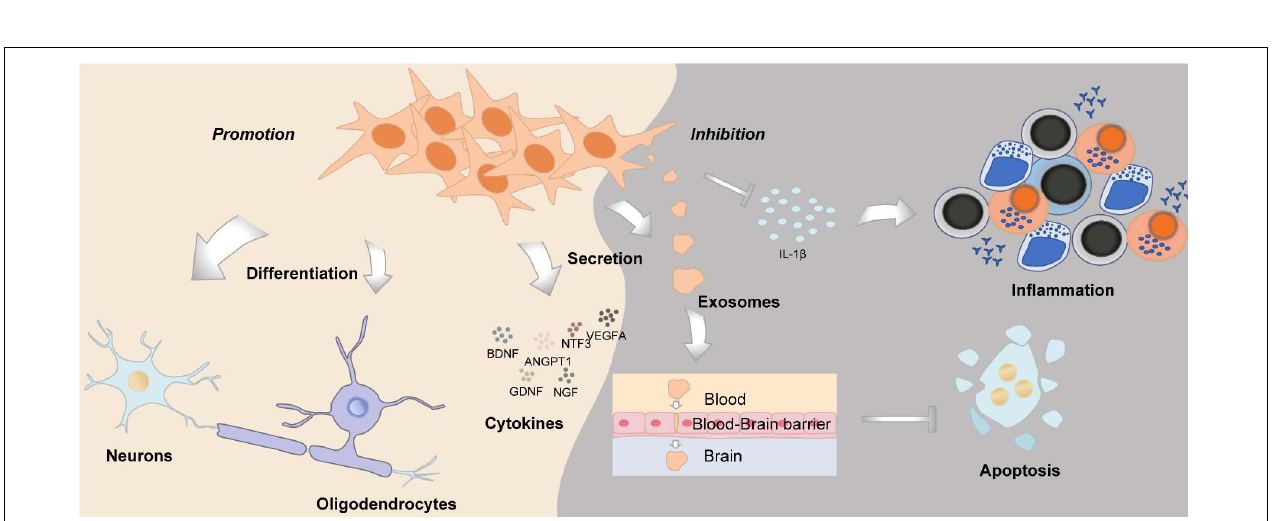
FIGURE 4 | The role of DMSCs in neurogenesis and neuroregeneration.